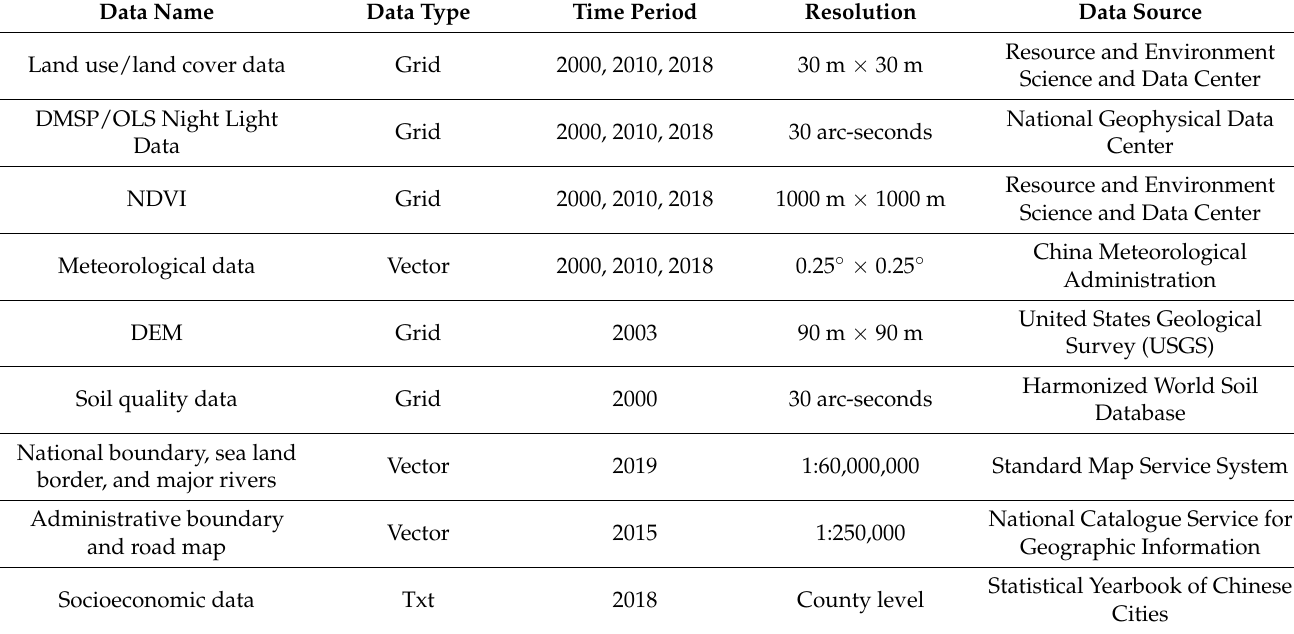
Table 1. Data sources and descriptions.